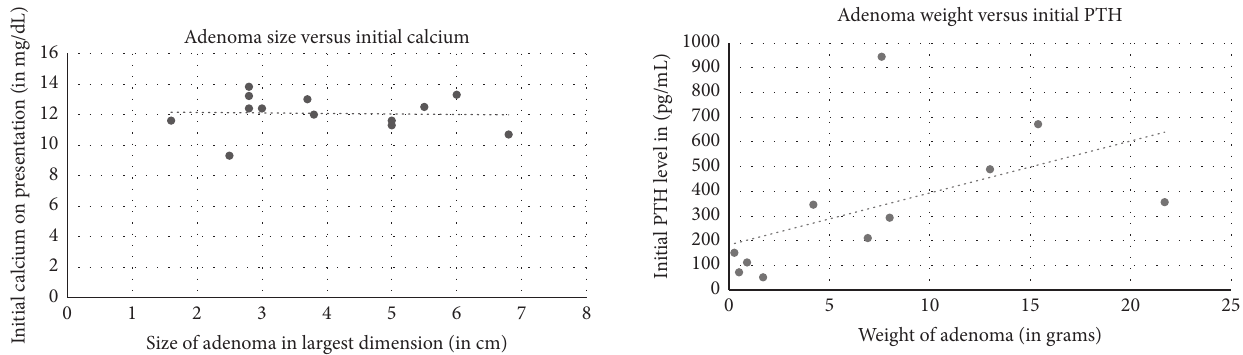
Figure 5: Size of adenoma on pathological evaluation correlation to initial calcium on presentation. Correlation coefficient − 0.04.